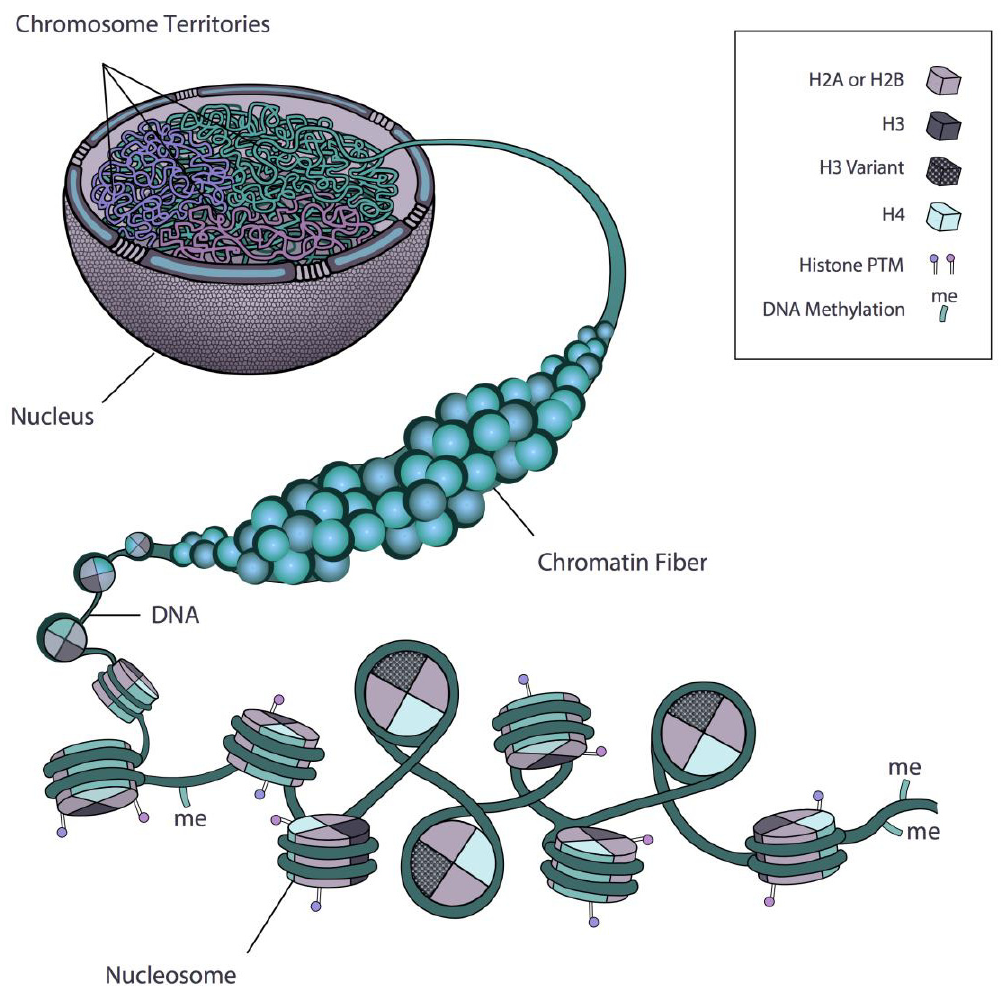
Figure 1. Organizational network of chromatin in the cell. Scheme depicting different aspects of chromatin regulation. PTM, post-translational modification. Chromosome territories within the nucleus, shown in different colours, are composed of chromatin fibres, which, in turn, contain packed